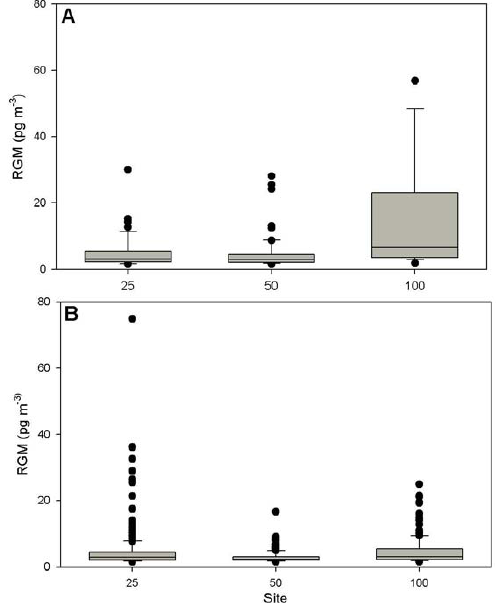
Fig. 7. Boxplots showing RGM results ( ≥ 1.5pgm − 3 ) for each site when winds are from the south (170–190; top panel A ) and from all other directions (190–170; bottom panel B ). Results do not show a Figure 7. Boxplots showing RGM results ( ≥ 1.5 pg m -3 ) for each site when winds are from the 7 south (170-190; top panel A) and from all other directions (190-170; bottom panel B). Results 8 consistent decrease in RGM concentration with distance from the do not show a consistent decrease in RGM concentration with distance from the large emission 9 large emission source due south of the 25km source due south of the 25 km site.10